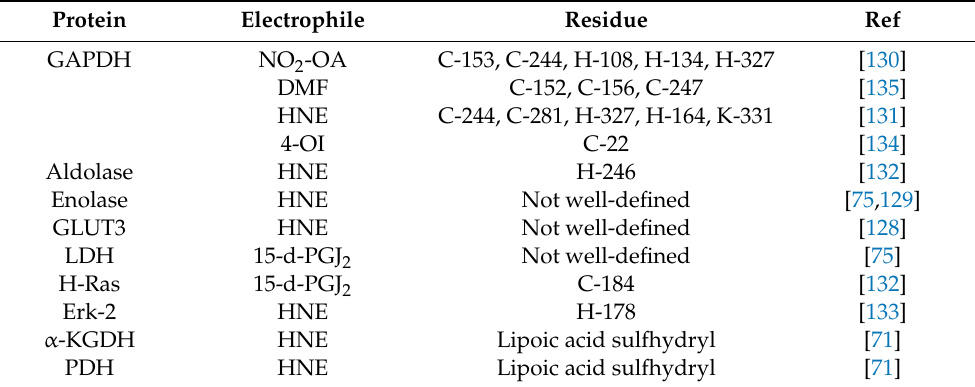
Table 1. A list of electrophilic molecules that have been shown to interact with glycolytic enzymes, as well as other proteins directly involved in